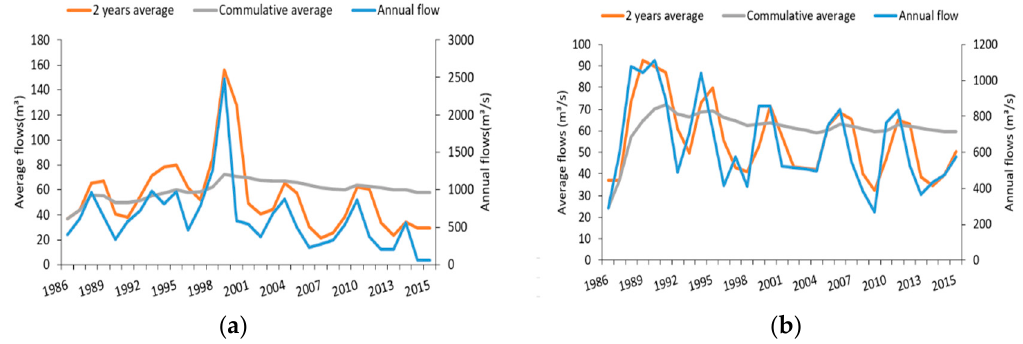
Figure 7. River flows along ( a ) the Wami estuary and ( b ) the Ruvu estuary.